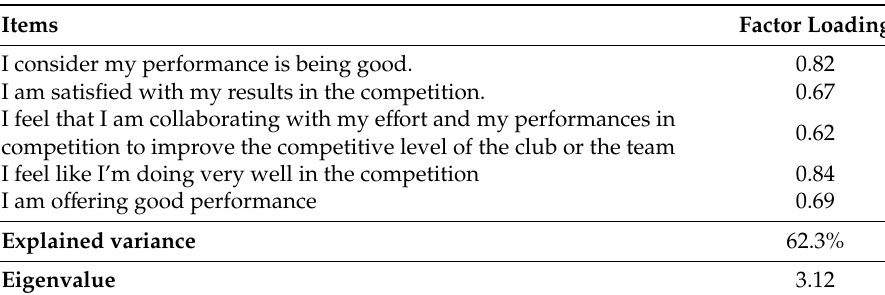
Table 1. Exploratory factor